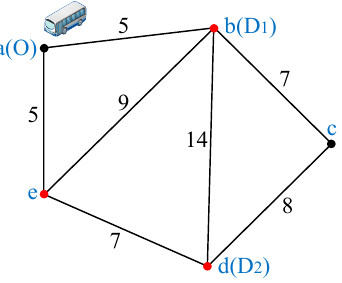
Figure 5. A five-node traffic network.